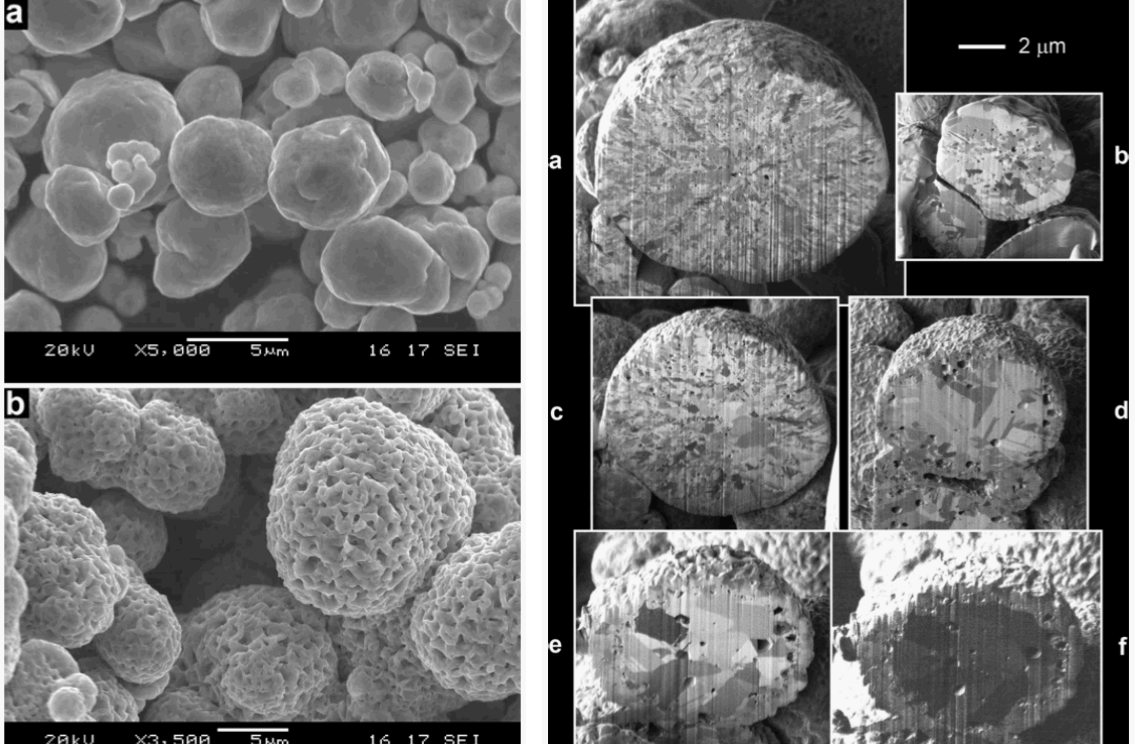
Figure 17. Left: SEM of ( a ) as received Ni and ( b ) fully oxidized Ni (NiO) particles. The secondary electron images were recorded using a beam energy of 20 keV. Right: FIB cross-sectional secondary electron images of Ni particles oxidized at 800 °C for ( a ) 30 s; ( b ) 60 s; ( c ) 90 s; ( d ) 180 s; and ( e ) 300 s. Image ( f ) is the same particle as in ( e ) but obtained using the secondary ion signal